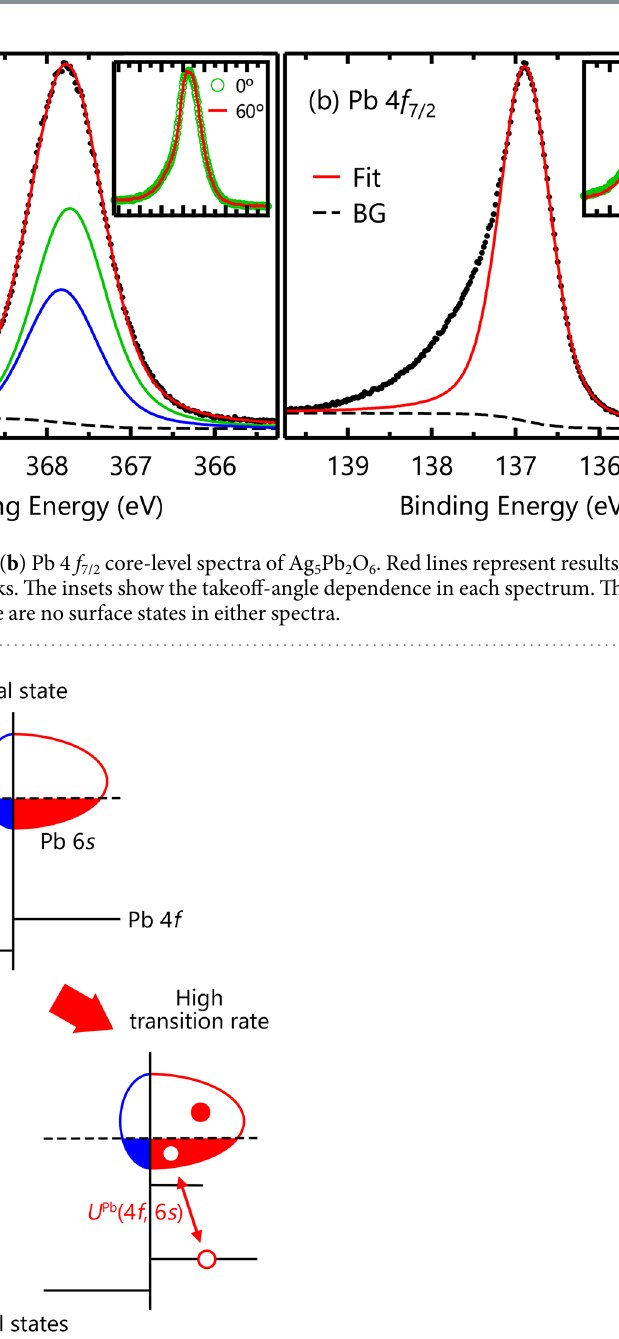
Figure 3. Schematic diagram of core-level photoemission in Ag 5 Pb 2 O 6 . A Pb-dominant character is assumed for the conduction electrons in the diagram. A Coulomb interaction between a Pb core hole and Pb conduction electrons generates electron-hole pairs in the E F -crossing